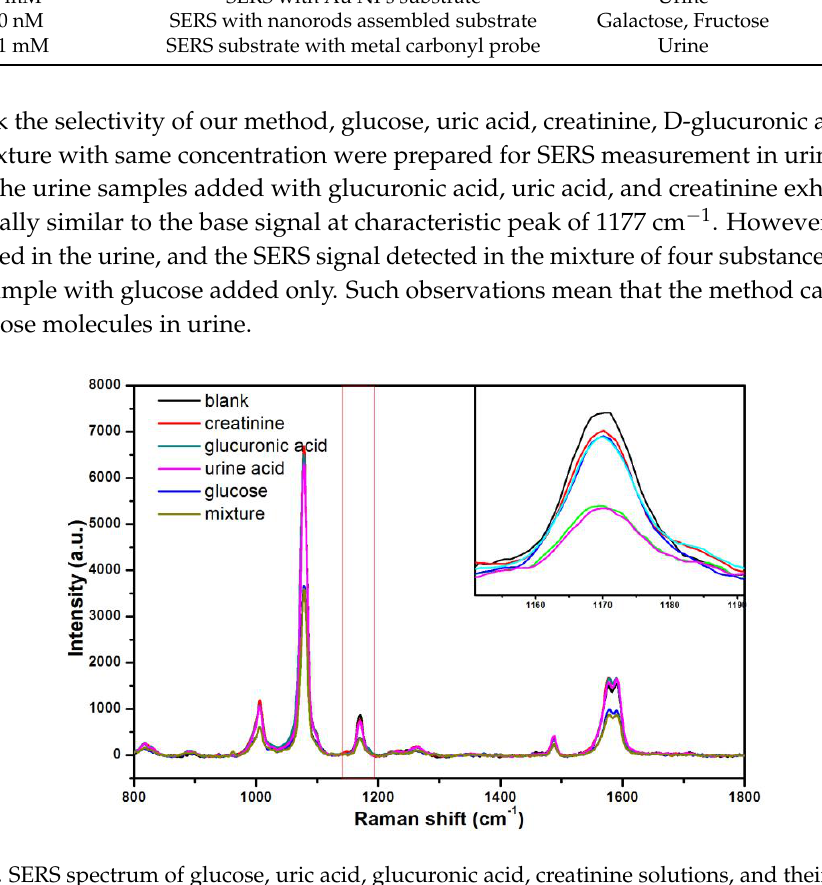
Figure 8. SERS spectrum of glucose, uric acid, glucuronic acid, creatinine solutions, and their mixture with same concentration (10 -3 M).